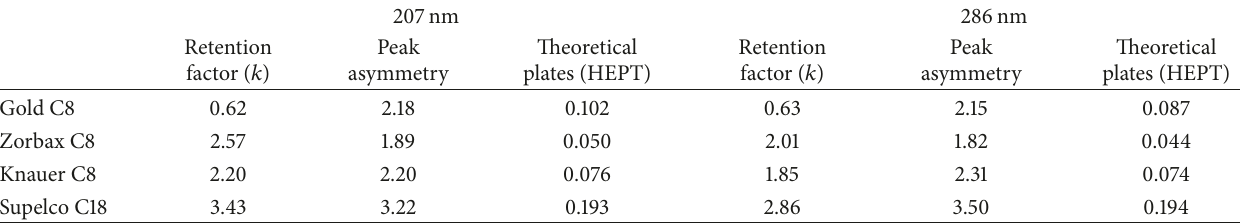
Table 1: The obtained retention factor, peak asymmetry, and numbers of theoretical plates of investigated columns.